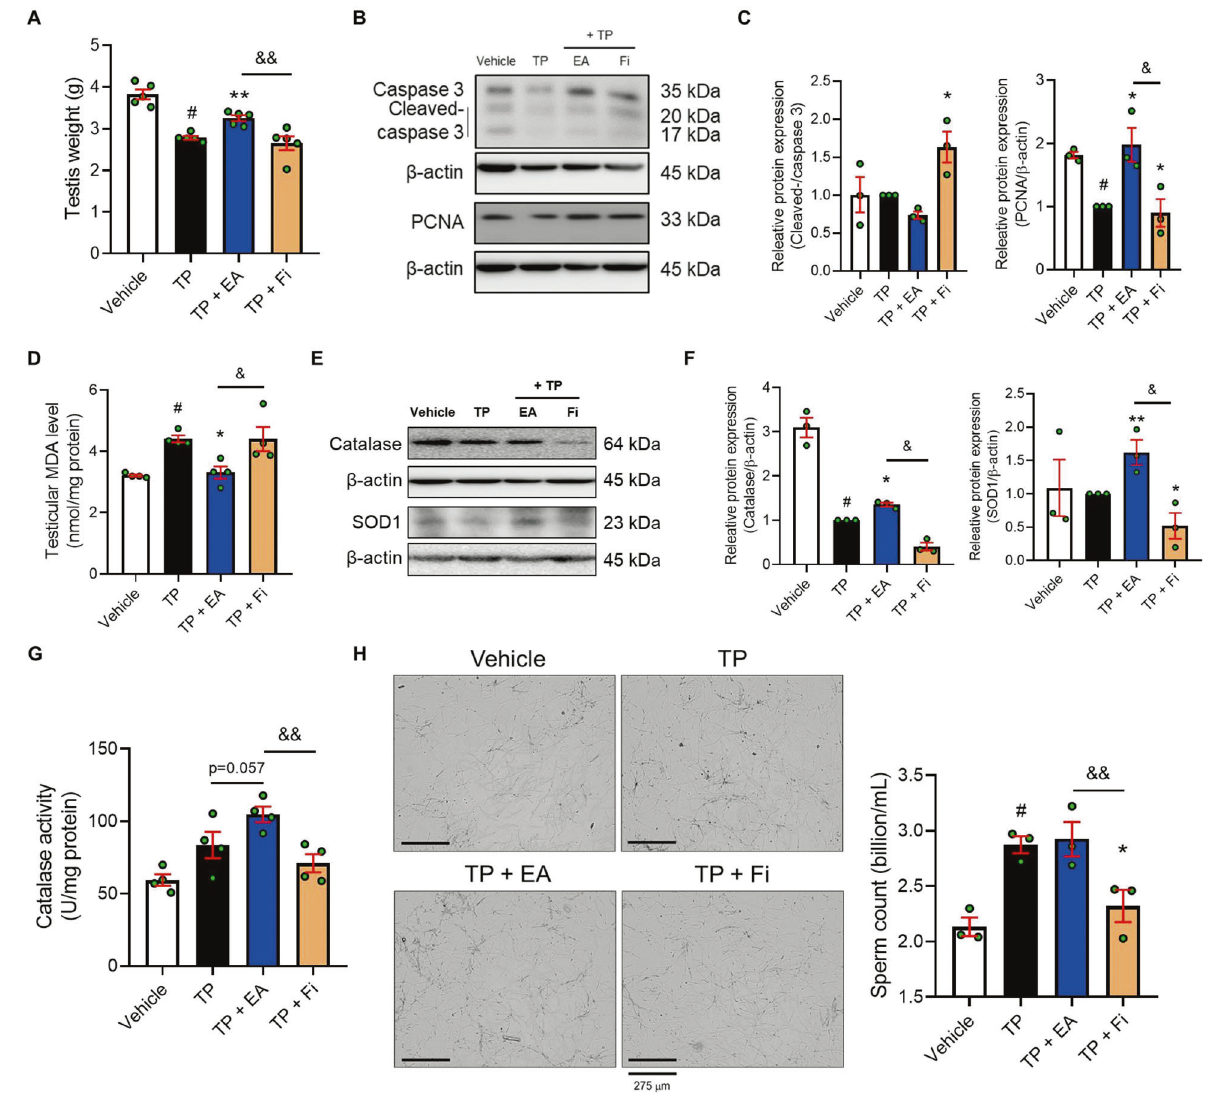
and PCNA were analyzed by Western blot analysis. D MDA level in testis was measured using ELISA kit. E , F Protein levels of catalase and SOD1 were analyzed by Western blot analysis. G Catalase activity in testis was measured using ELISA kit. H Representative images of epididymal sperm (magni fi cation 100×, scale bar 275 μ m) were expressed, and sperm count was measured using ImageJ software. The loading control was β -actin. All data are expressed as the mean ± S.E.M. of data from three or more separate experiments. Statistical differences were evaluated using the unpaired t -test and a subsequent post-hoc one-tailed Mann – Whitney U -test. # p < 0.05 vs. vehicle group, * p < 0.05 and ** p < 0.01 vs. TP group, & p < 0.05 and && p < 0.01 vs. Fi group. TP testosterone propionate, EA ellagic acid, Fi fi